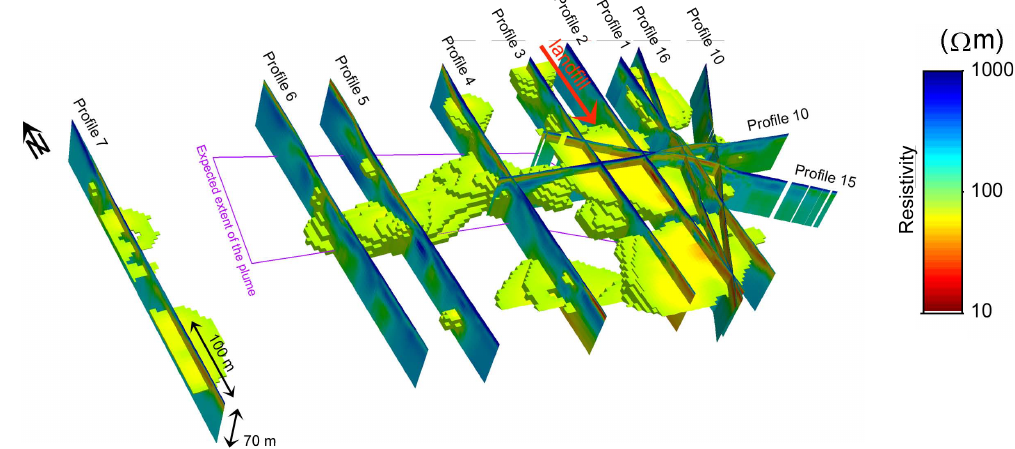
Fig. 11. Delineating the deep clay layer with the DC method: 3-D view of gathered resistivity sections with isovolume of resistivities lower than 100 (cid:127) m. The anticipated extent of the plume is drawn in purple.